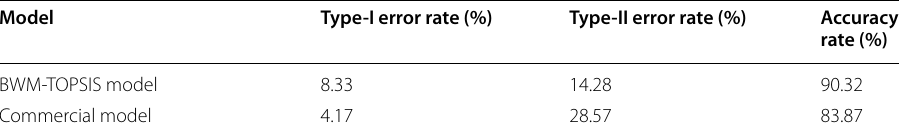
Table 13 Type-I, Type-II error and accuracy rate compared to a commercial model